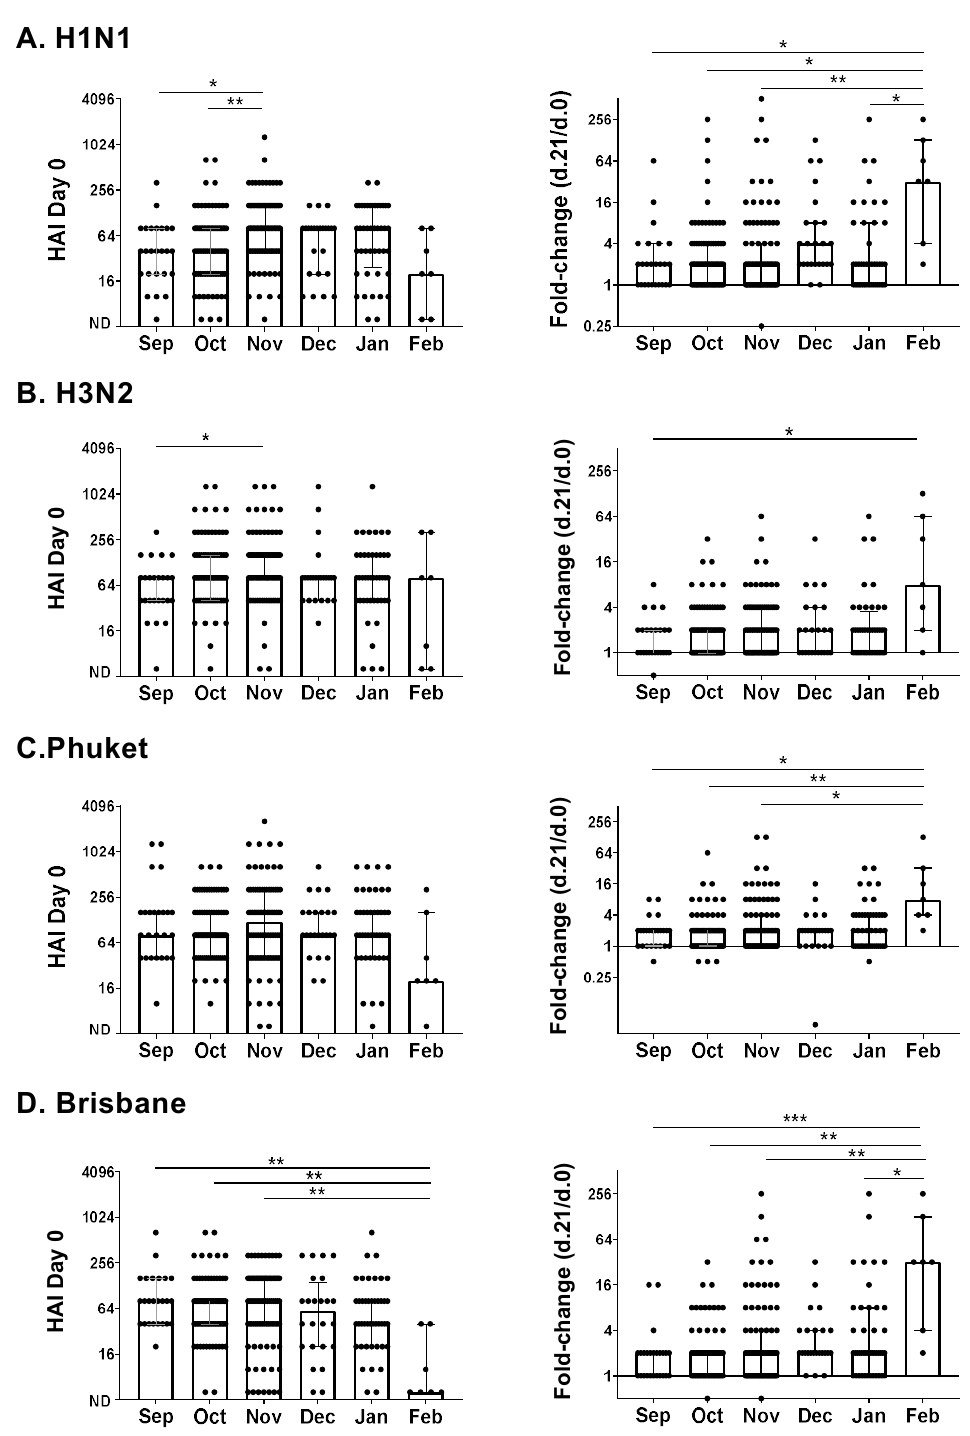
Figure 2. HAI responses by month of vaccination in an adolescent/adult influenza vaccine study. Participants ( n = 271) received the influenza virus vaccine during the 2017–2018 season. They were vaccinated in September ( n = 25), October ( n = 83), November ( n = 88), December ( n = 24), January ( n = 44), and February ( n = 7). Baseline (Day zero) HAI titers and fold-change values (Day 21 compared to Day zero titers) are shown as symbols (dots) for each volunteer. Negative scores (ND = not detected) were assigned a value of 5. Target viruses were ( A ). H1N1(A/Michigan/45/2015 H1N1), ( B ). H3N2 (A/Hong Kong/4801/2014 H3N2), ( C ). Phuket (B/Phuket/3073/2013), and ( D ). Brisbane (B/Brisbane/60/2008). Data were categorized by the month of vaccination, and analyzed as in Figure 1. Results of statistical analyses are shown by asterisks (* p < 0.05; ** p < 0.01; *** p < 0.005).